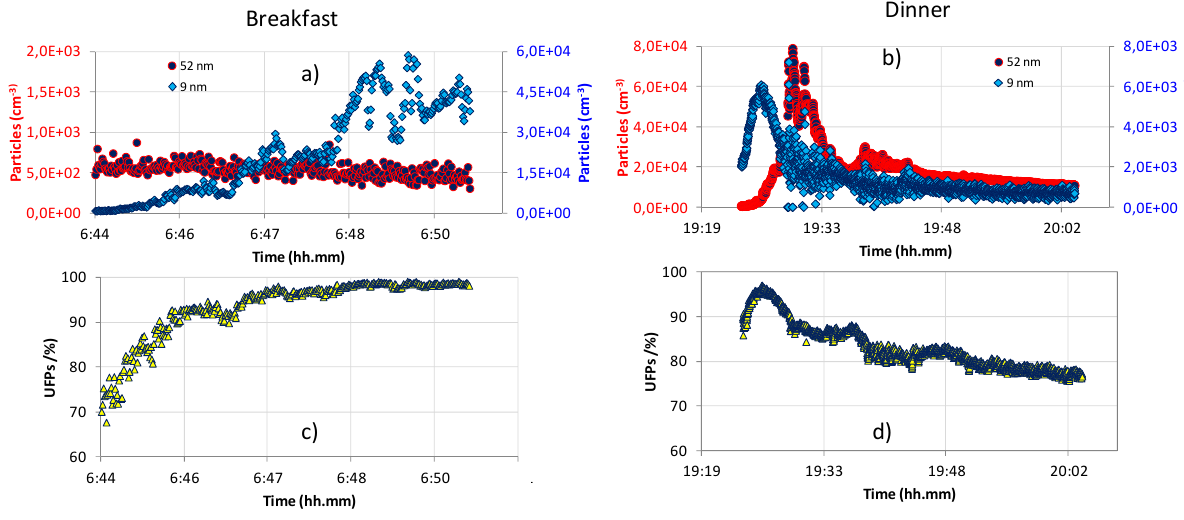
Figure 3. Temporal trends of 9-nm and 52-nm sized particles for ( a ) breakfast (milk heating) and ( b ) dinner (meat grilling) preparation and of the ultrafine particle (UFP) %